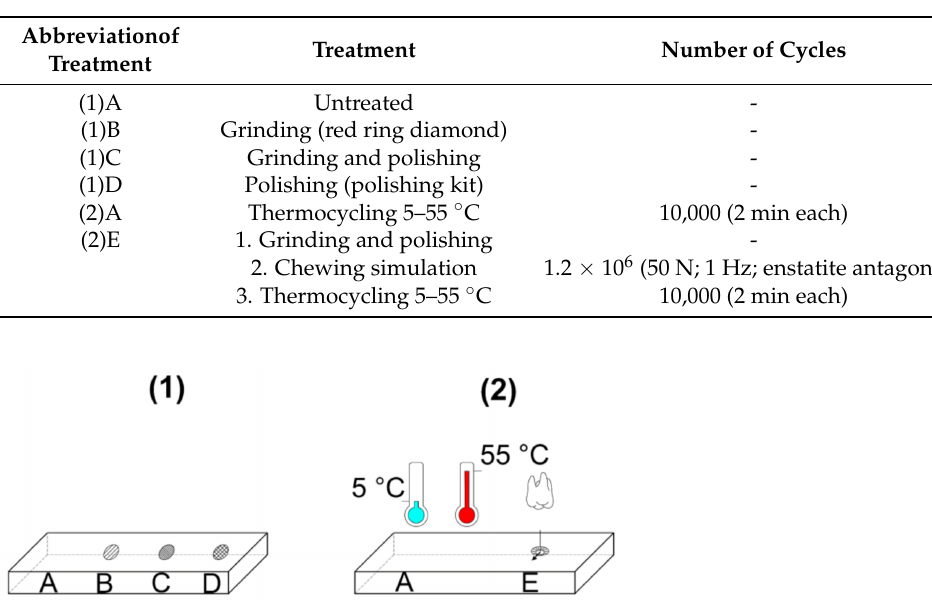
Table 2. Description of the different types of treatment: (Sample plate: (1)—without thermocycling (TC), (2)—with thermocycling (TC) and chewing simulation). Number: Abbreviations of surface treatments.